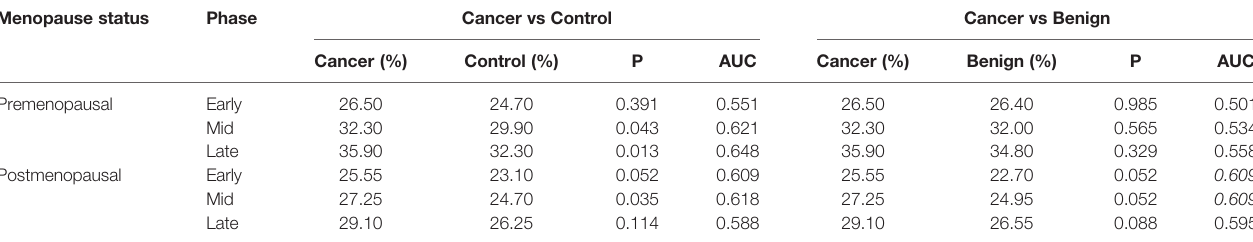
TABLE 3 | Comparison of BPE I and its AUC among cancer vs control and cancer vs benign. Menopause status